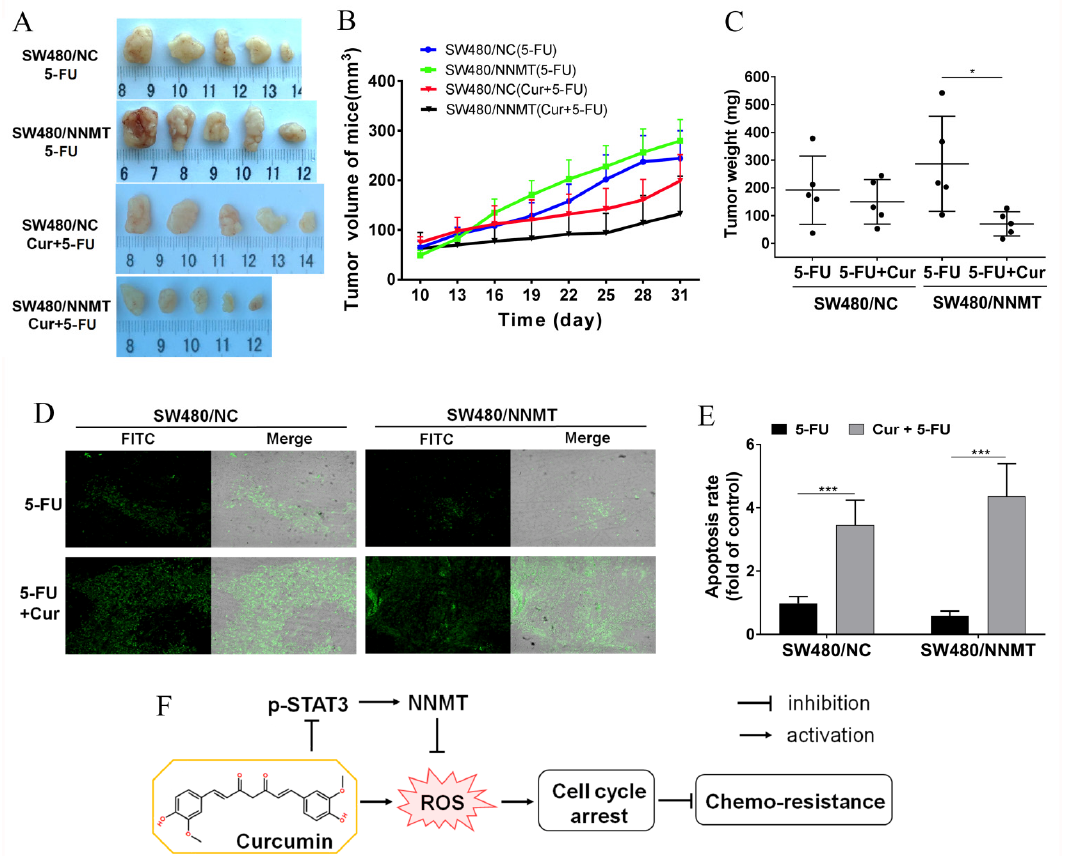
Figure 8. Cur inhibits tumor growth in a mouse xenograft model. ( A ) Representative picture showing tumors from subcutaneous tumor-bearing nude mice of SW480/NC or SW480/NNMT, groups which were treated with 5-FU and/or Cur. ( B ) Tumor proliferation curves calculated by tumor volume from day 10 to day 31. ( C ) Tumor weight of different groups displayed as a scatter diagram. ( D ) Cell apoptosis of tumor sections detected by TUNEL staining ( × 100). ( E ) Cell apoptosis rate calculated from TUNEL staining displayed as a histogram. The SW480/NC group treated with 5-FU was set as the control group and was set as 1. ( F ) Schematic illustration of Cur in the regulation of NNMT and chemo-sensitivity in CRC cells. Cur downregulates NNMT and p-STAT3 and enhances sensitivity to 5-FU via ROS-induced cell cycle arrest in CRC cells. 5-FU: 5-Fluorouracil, Cur: curcumin. Data are expressed as means ± SD, n = 3, * p < 0.05, *** p <